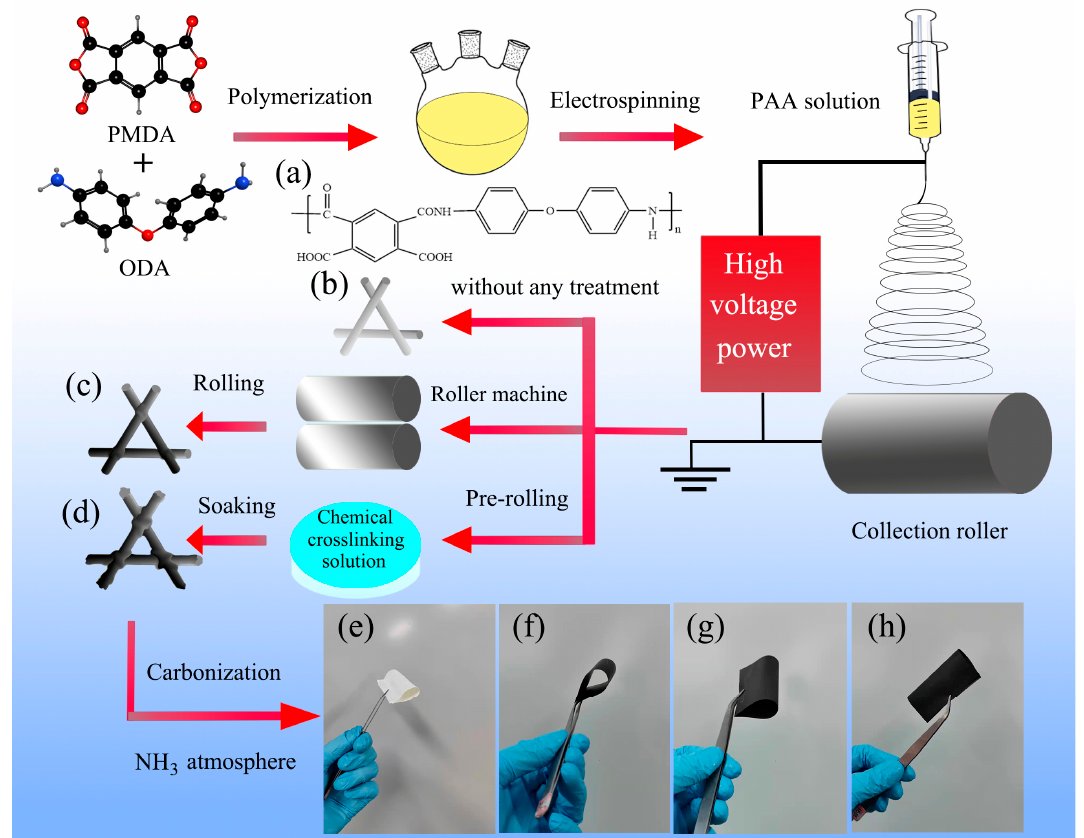
Figure 1. Schematic illustration for fabrication process of carbon nanofiber membranes. ( a ) The chemical structure of PAA (polyimide precursors), ( b ) PAA nanofiber membranes (PAANMs) without any treatment, ( c ) PAANMs-PC, ( d ) PAANMs-CC, corresponding optical photographs of ( e ) PAANMs, ( f ) CNMs, ( g ) CNMs-PC, and ( h ) CNMs-CC in the bent state.